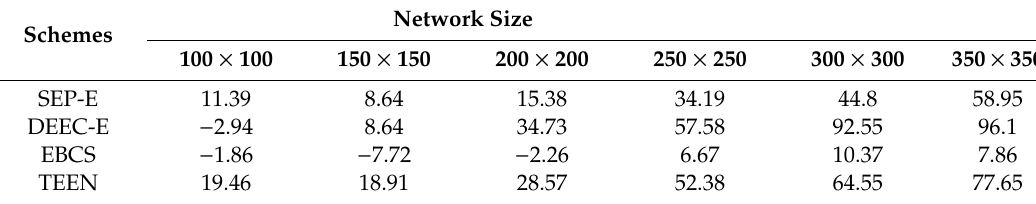
Table 13. Percentage improvement of HFECS in terms of network lifetime